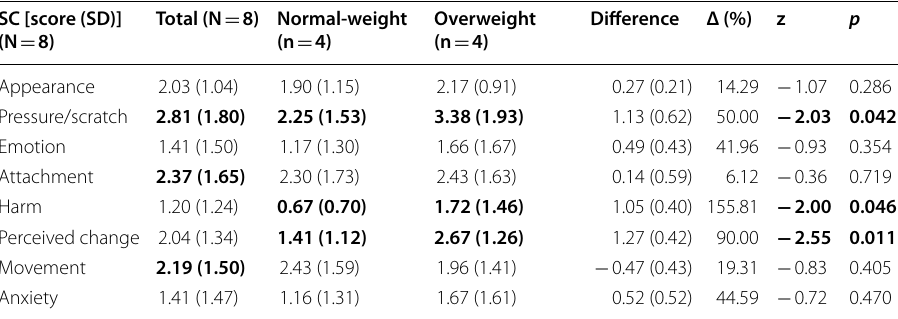
Items in bold: significant t-value SC subjective comfort, SD standard